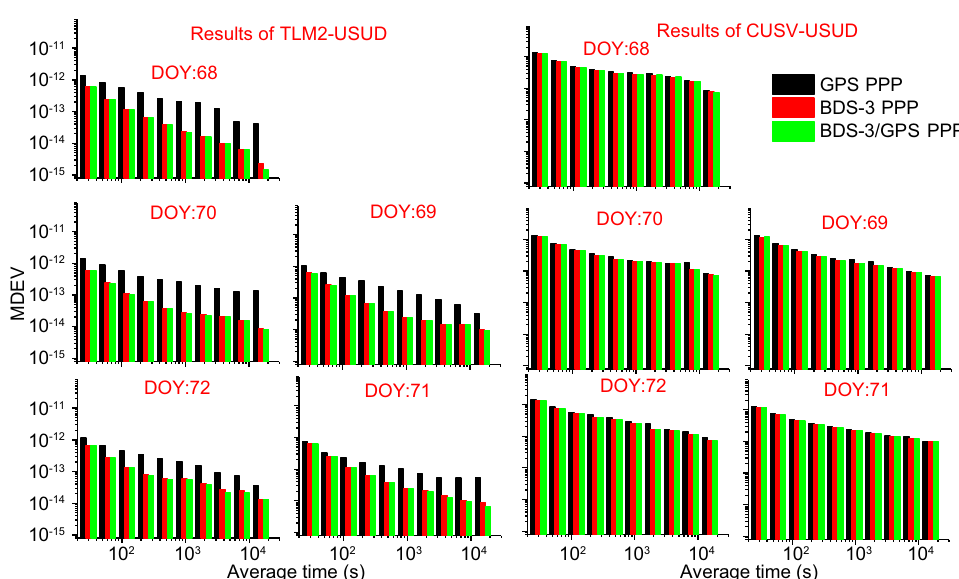
for CUSV-USUD and (5.92 10 –14 , 8.56 10 –15 , × × 7.77 10 –15 ) for TLM2-USUD for GPS, BDS-3, and × BDS-3/GPS time transfer using the PPP-B2b service. BDS‑3 and BDS‑3/GPS PPP with/without the clock model As we pointed out earlier, GPS PPP with the PPP-B2b correction is not suitable for modeling. Hence, BDS-3/ GPS or BDS-3 PPP time transfer using the PPP-B2b cor- rection with/without the clock model was studied. The receiver clock offsets at CUSV, USUD, and TLM2 esti- mated from BDS-3 PPP using the PPP-B2b correction with/without the clock model are displayed in Figs. 8